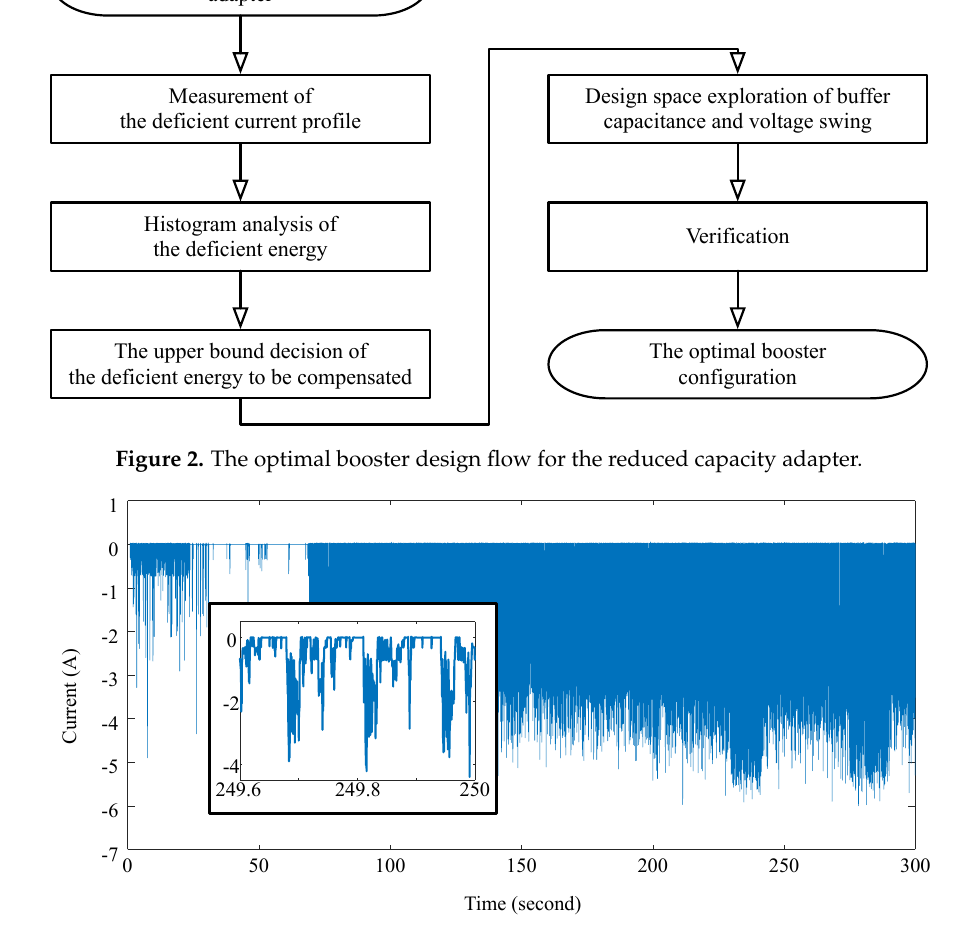
Figure 3. Current profile of gaming workload with an almost fully charged